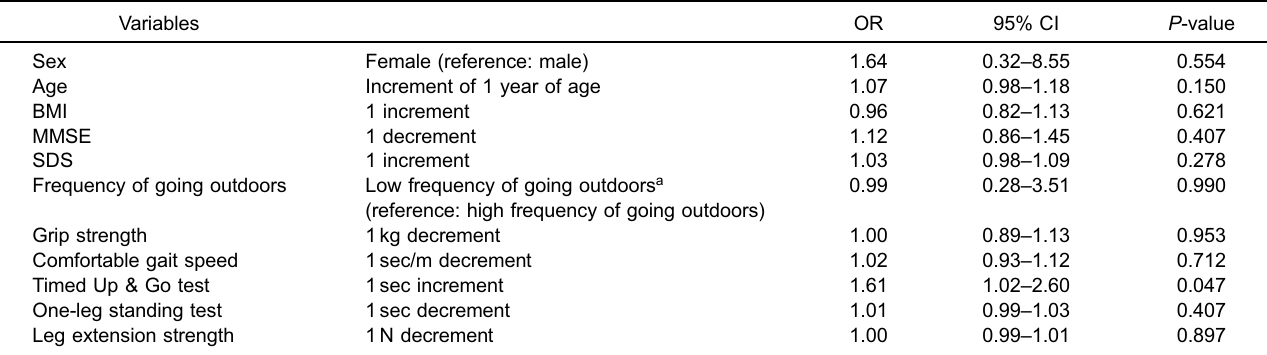
Table 3. Logistic regression analysis of the inability to ride a bicycle among older adults with mobility limitations ( n = 123) Variables